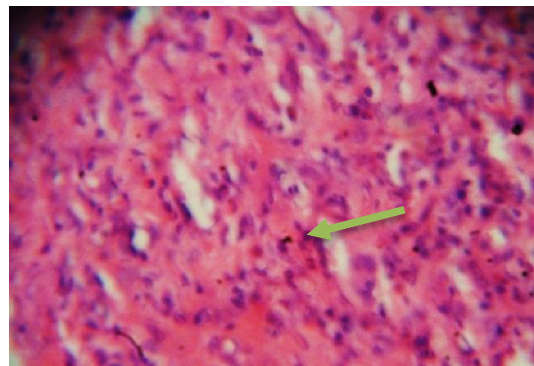
Figure, 12: Shows lesion characterized by granulation composed from blood vessels and fibroblast extends in the wound area, 14 days post operation treated group (H&E 40